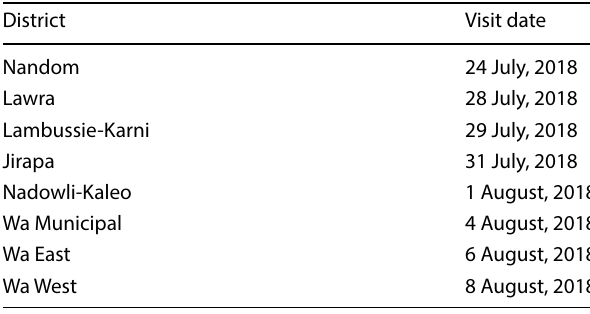
Table 2 Summaries of districts and the dates of entry